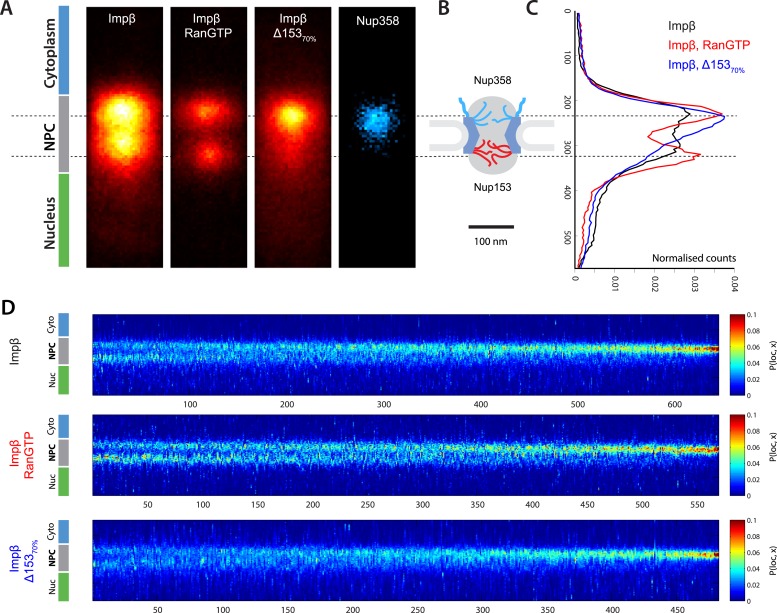
Localization microscopy of impβ spatial organisation and its Ran-dependence.(A) 2D histograms of impβ density in the NPC under different conditions. To generate these panels, we sum all localizations for a given condition and divide by the number of NPCs per condition. Figure 3—figure supplement 1 shows examples of the raw localization images for each of the conditions. Anti-Nup358 antibody was localized using a second dye pair, as shown in Figure 3—figure supplement 2. Histograms of the number of localizations per NPC, for each condition are shown in Figure 3—figure supplement 3. (B) Schematic of the NPC showing the tethering locations of Nup358 and Nup153. (C) Probability density functions (PDF) of impβ localizations, showing the relative redistribution of impβ localizations in the presence of RanGTP and with Nup153 knockdowns. (D) 'Waterfall' plots showing PDF projections of NPC structures in each of the conditions tested. Each column of the plot represents a single NPC structure and is arranged from left to right according to the ratio of cytoplasmic to nuclear localizations.